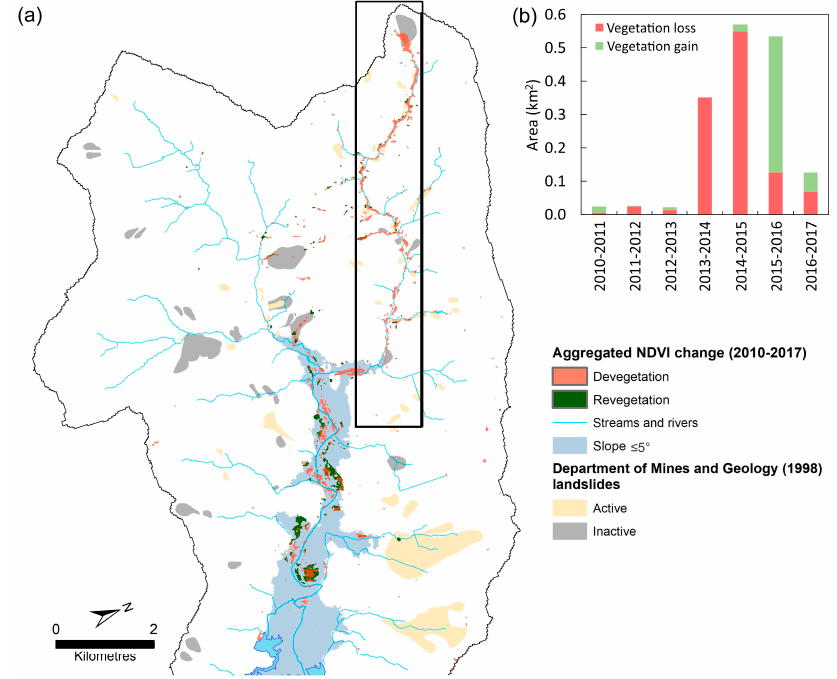
Figure 7. ( a ) Landslides and normalised difference vegetation index (NDVI) change in the Phewa Catchment. Inset box refers to Figure S3. ( b ) Areas of change in NDVI from 2010–2017.